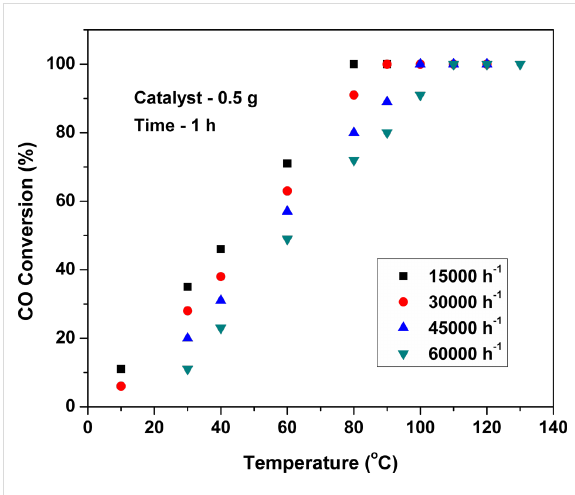
Figure 10: Effect of GHSV on CO conversion over Pt(1%)-ZrO 2 .